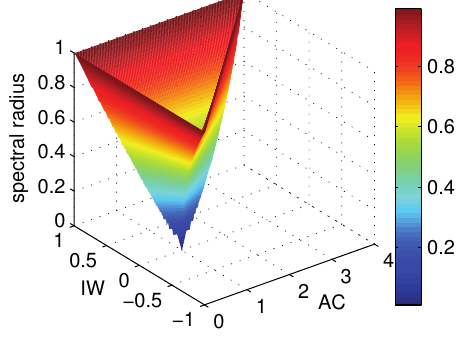
Figure 2: Spectral radius of the simplified PSO